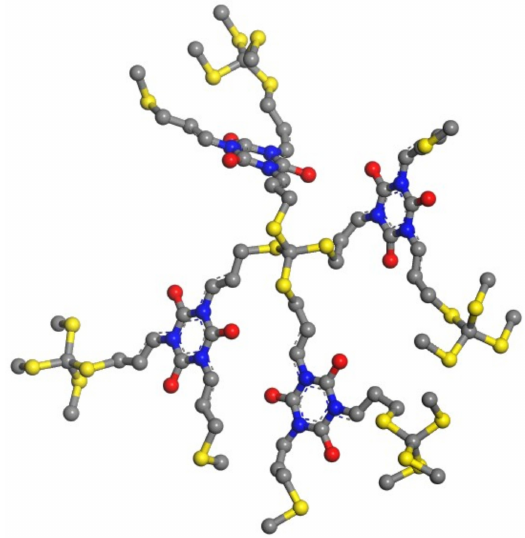
Figure 11. Representation of the crosslinked PETMP-TTT polymer network